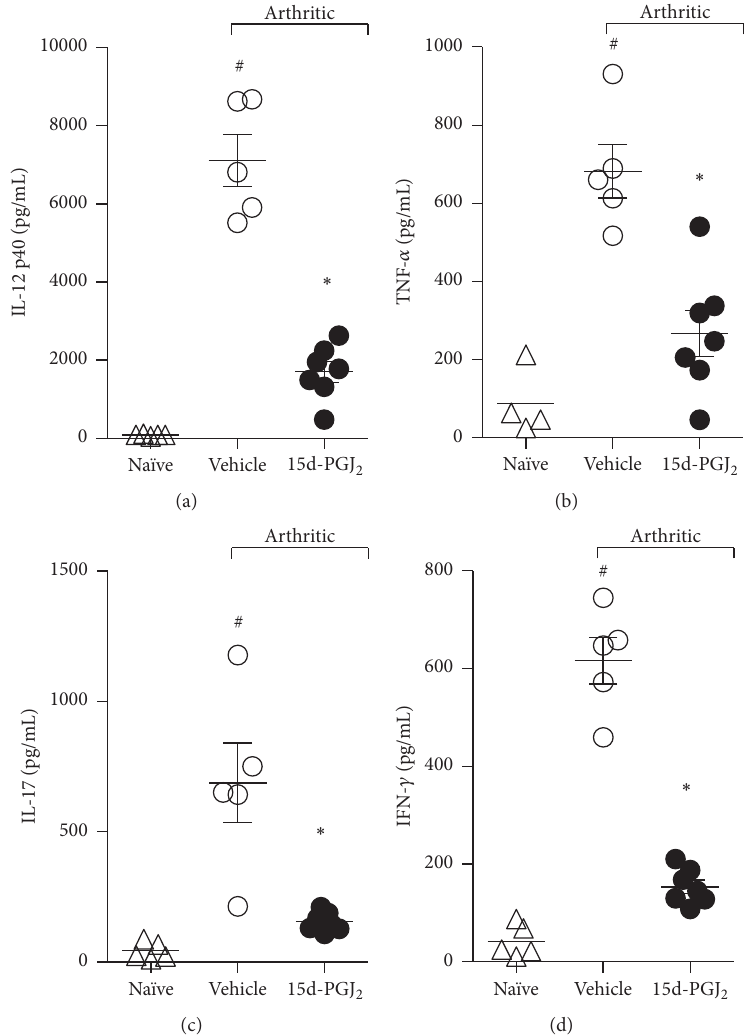
Figure 3: Decreased inflammatory cytokines in articular joints from 15d-PGJ 2 -treated arthritic mice. Ankle joints from na¨ıve ( Δ ) or PBS- ( I ) or 15d-PGJ 2 -treated ( e ) arthritic mice were collected after 7 days of treatment for the determination of TNF- 𝛼 (b), IFN- 𝛾 (d), IL-17 (c), and IL-12 (a) levels by ELISA in the homogenate supernatants. Results are expressed as the mean ± SEM, N = 4 (na¨ıve) and 9-10 (arthritic groups). # 𝑃 < 0.05 compared with na¨ıve group. ∗ 𝑃 < 0.05 compared with arthritic mice treated with PBS